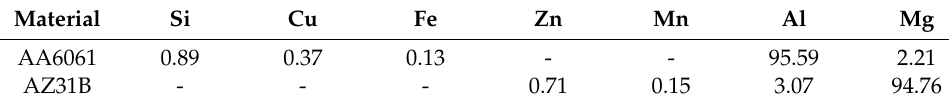
Table 1. The chemical composition (wt%) of AA6061-T6 and AZ31B.